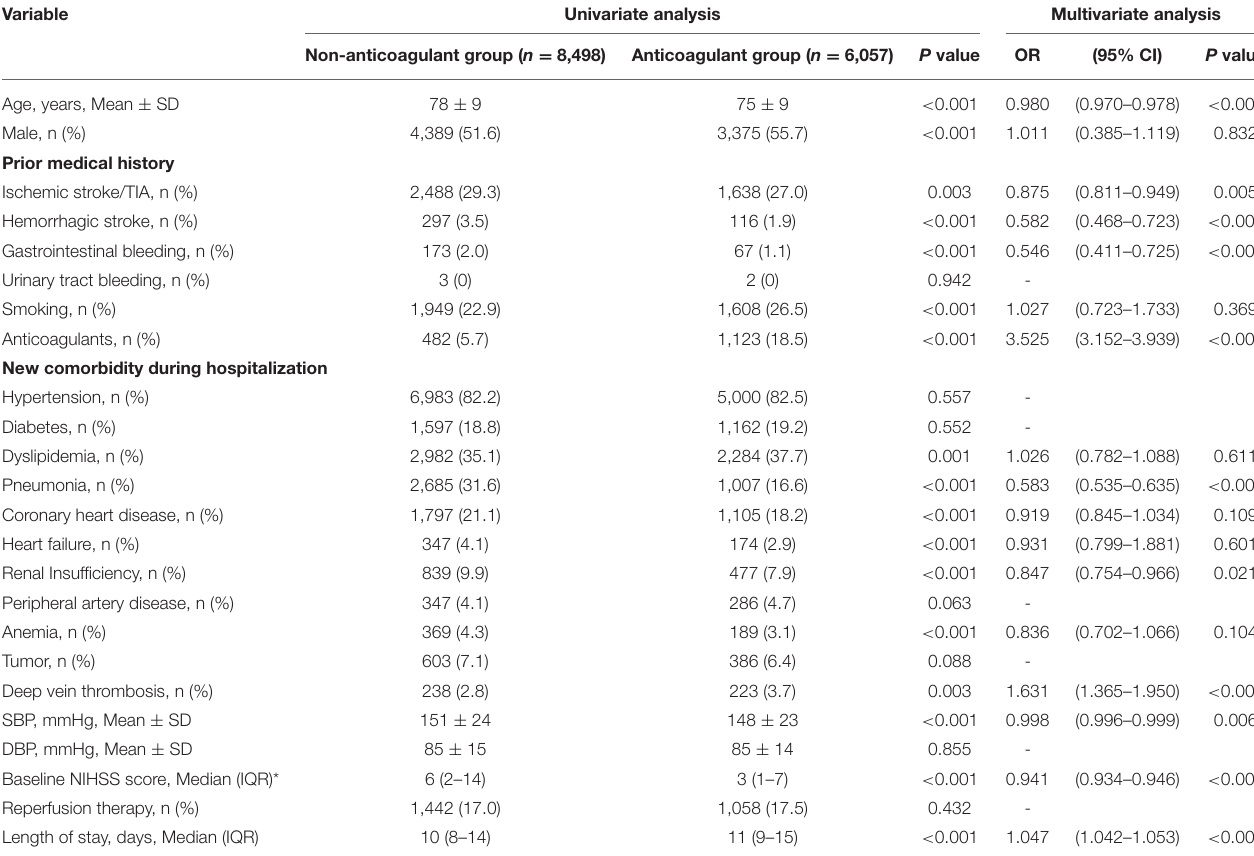
TABLE 3 | Univariate and multivariate analysis for the initiation of anticoagulation at discharge in patients without systemic bleeding during hospitalization. Variable Univariate analysis Multivariate